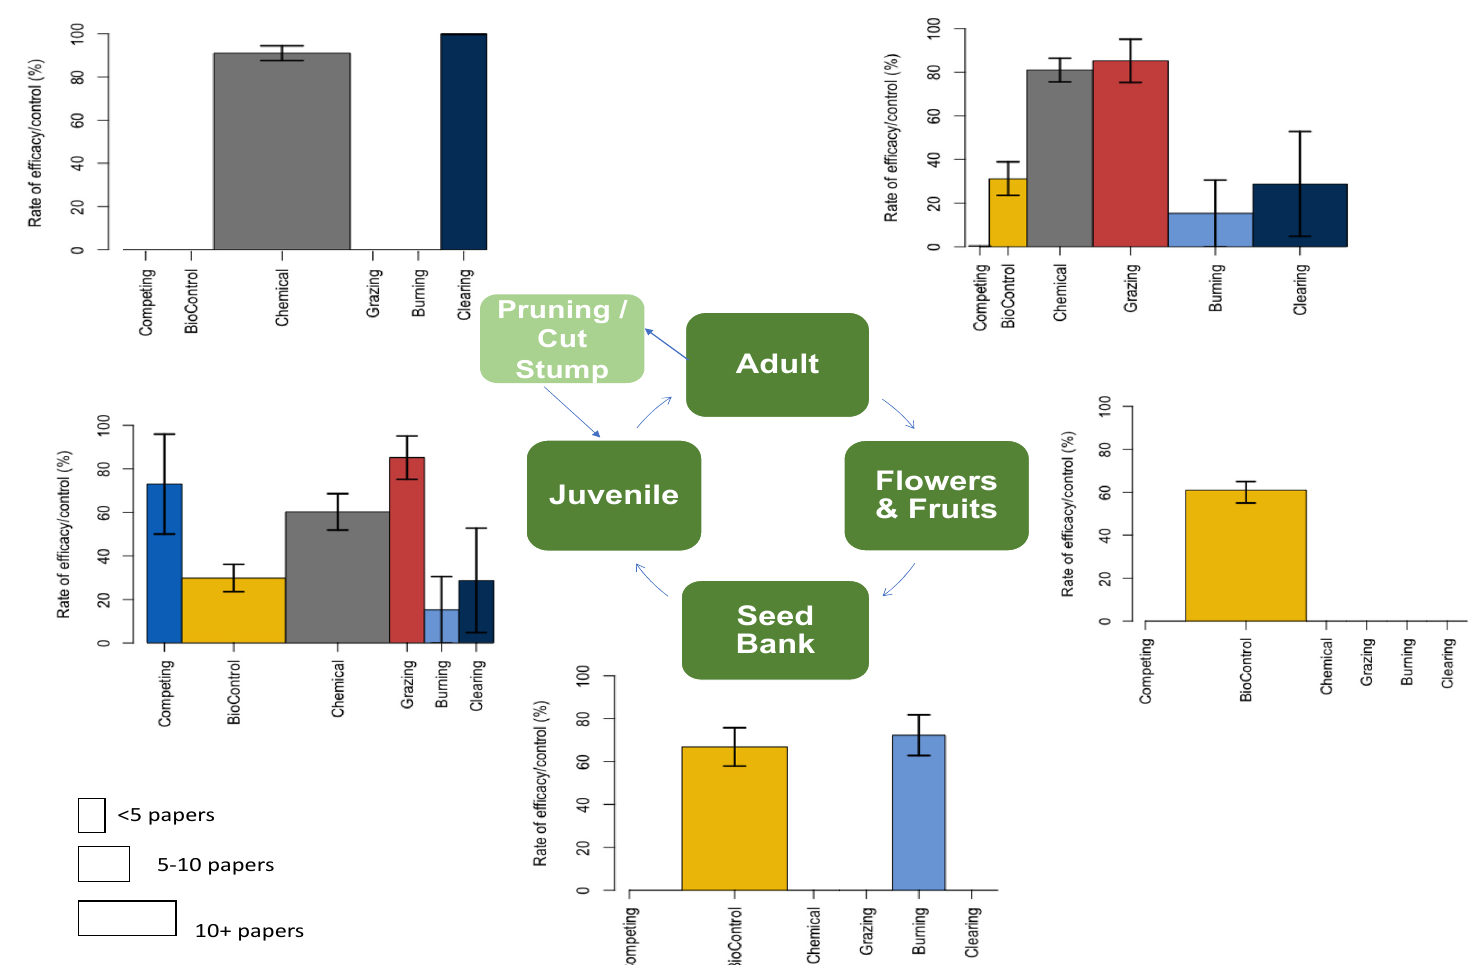
Figure 3. Rate of reported success (± S.E.) and paper number ( x -width) of various management actions (royal blue = competition; yellow = biological control; grey = chemical controls; red =grazing; light blue = burning; indigo = clearing) targeted at different lifecycle stages of common gorse: competition; biological control; chemical herbicides; grazing; burning; land clearing.